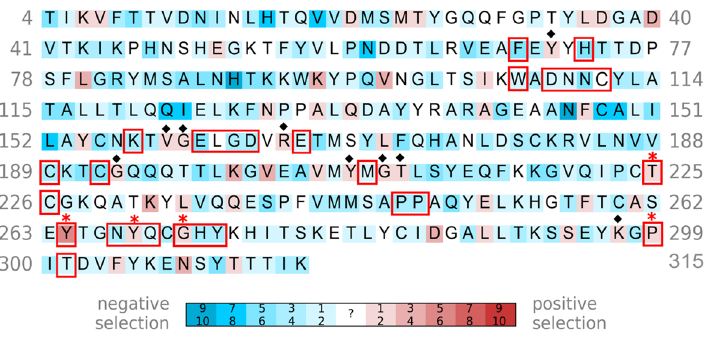
Figure 4. Selection pressure of SARS-CoV-2 PL pro residues. PL pro residues under increasing negative and positive selection are depicted by increasing blue and red intensity, respectively, whereas those with no evidence to support negative or positive selection are in white. All drug-interacting residues are boxed and those under positive selection are indicated by red asterisks. Residues under positive selection neighboring drug-interaction sites are indicated by black